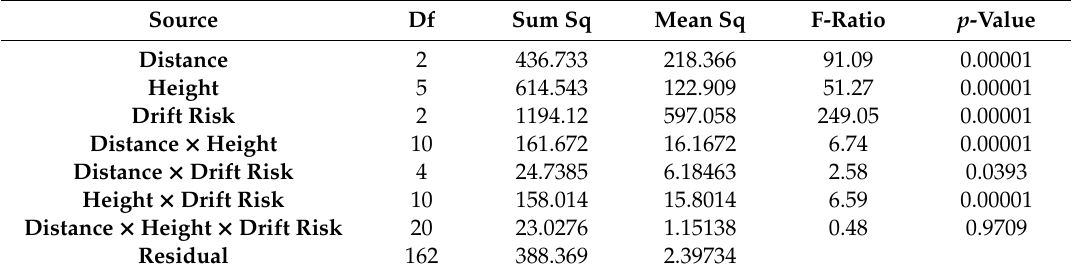
Table 8. Results of ANOVA for airborne spray drift as a ff ected by distance, height, and drift risk indication.